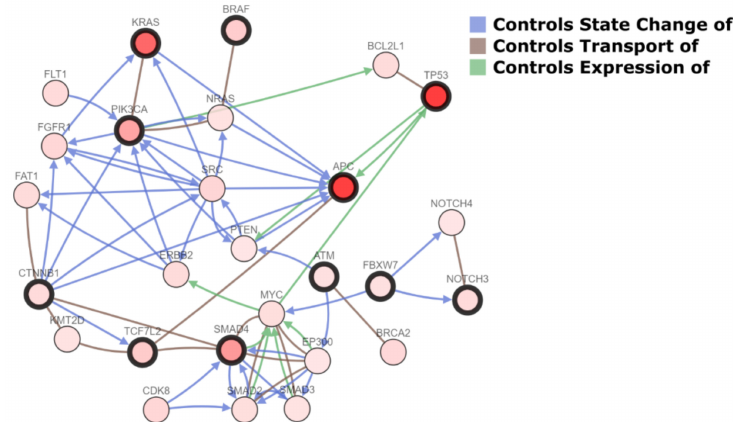
Figure 3. Network of the interactions between the most frequently altered genes in colorectal cancer liver metastases (highlighted in bold) and other cancer genes. Interaction types (arrows and lines) are color-coded on the basis of the legend at the top right.